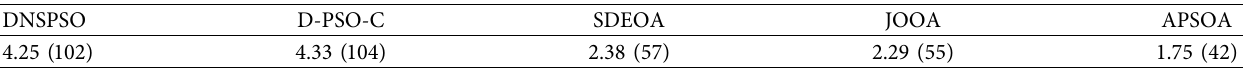
Table 9: Summary of the results presented in Table 8 (average rank of each method on all the functions of numerical optimization problems of the CEC 2010 benchmark and some real-world problems).